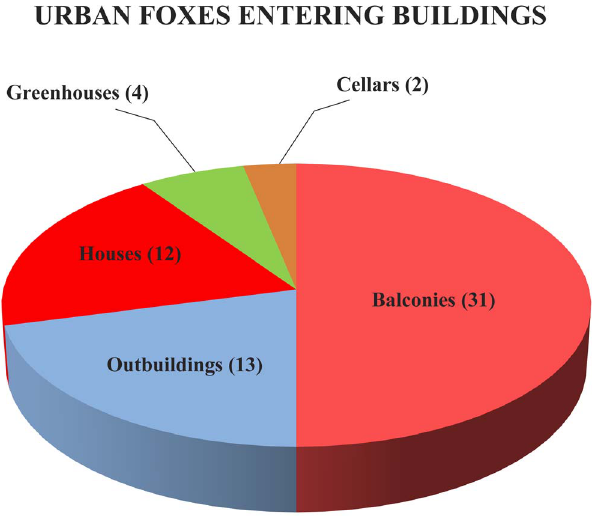
Fig. 5. Different buildings exploited by urban foxes in Estonia (see also Table 1). Numbers indicate the number of people reporting fox